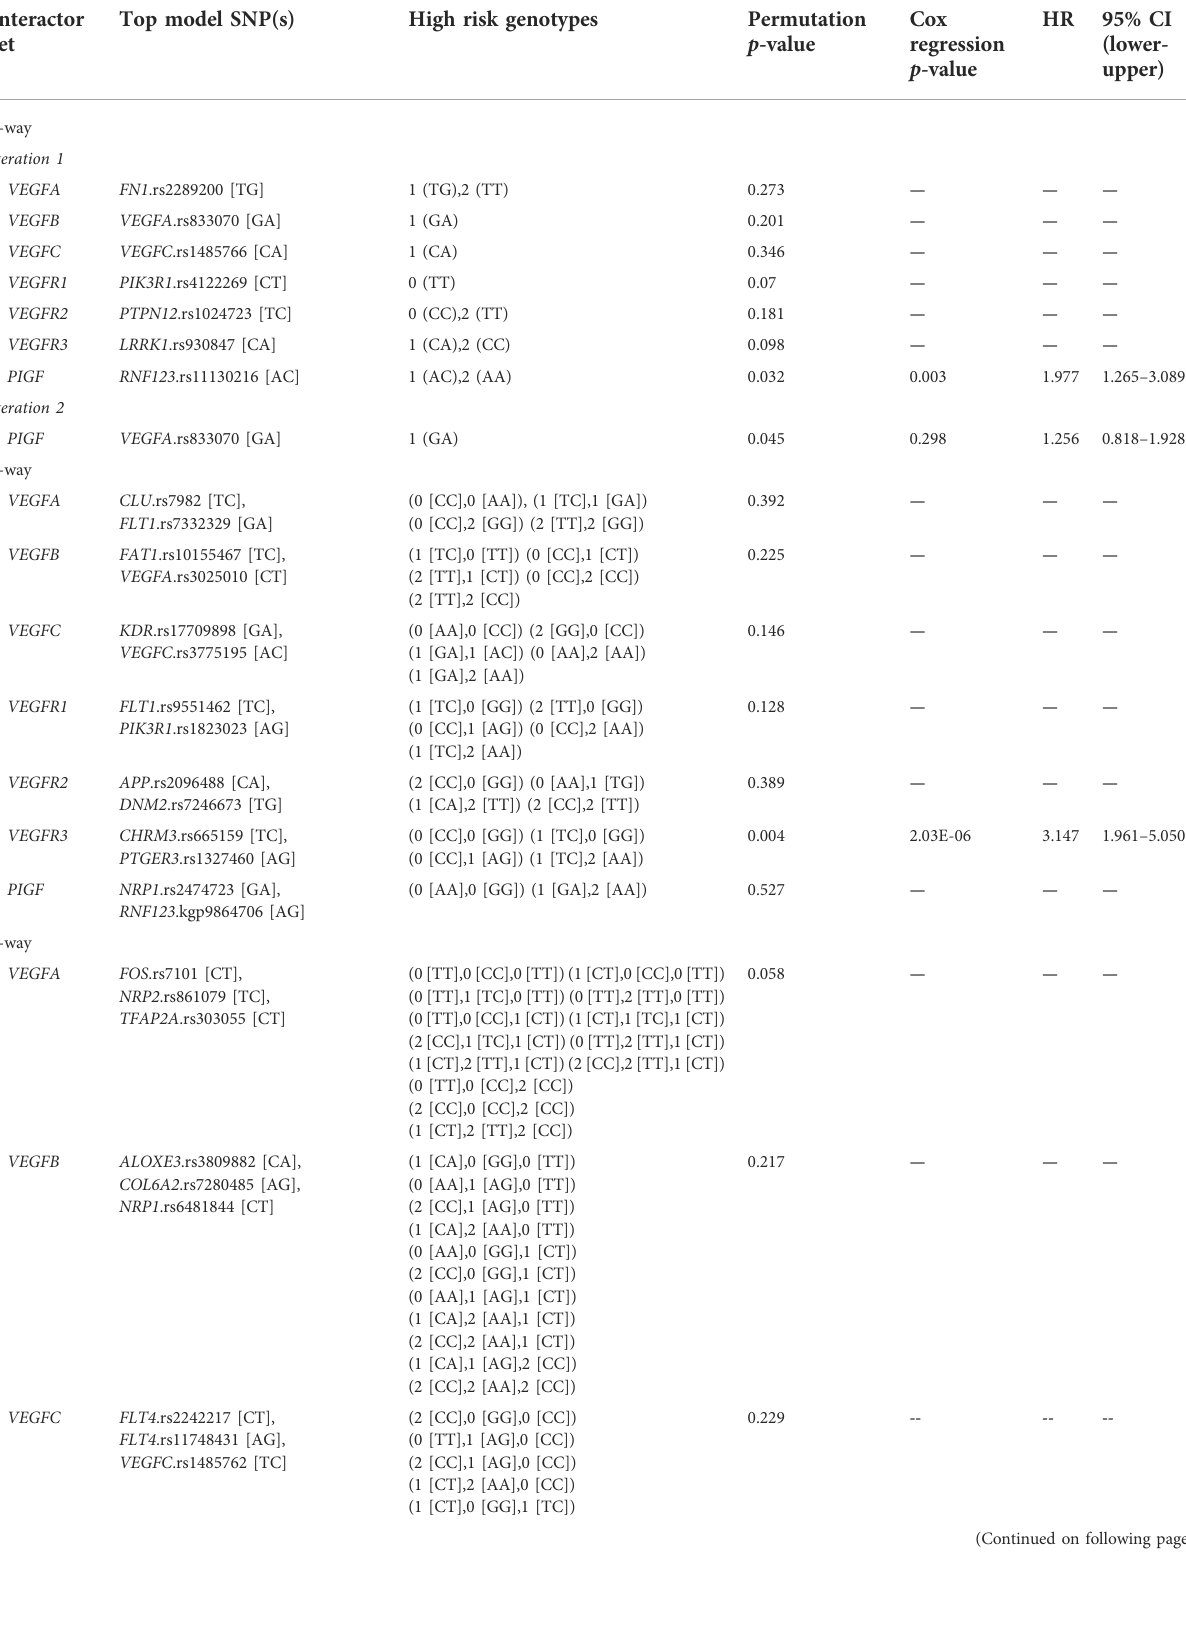
TABLE 3 Permutation testing and multivariable Cox-regression analysis results for the top Cox-MDR models in the VEGF interaction network set analyses (disease speci fi c